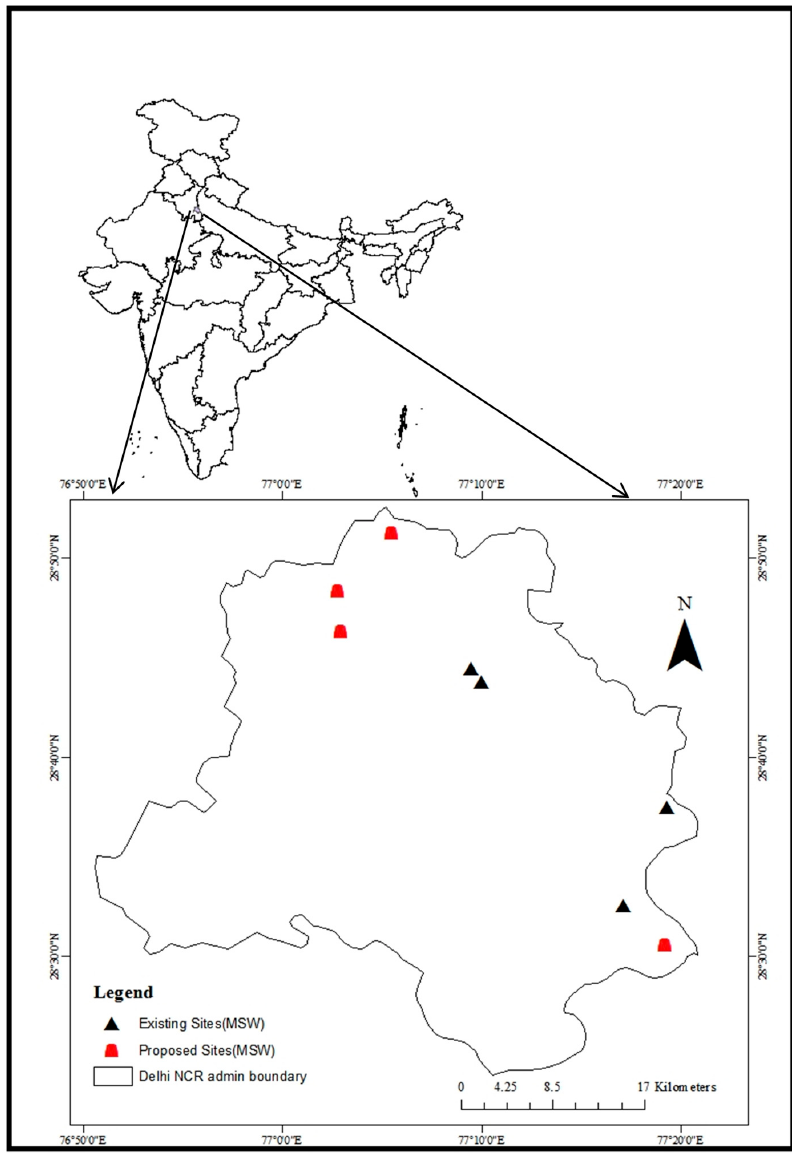
Figure 1. Study area map.